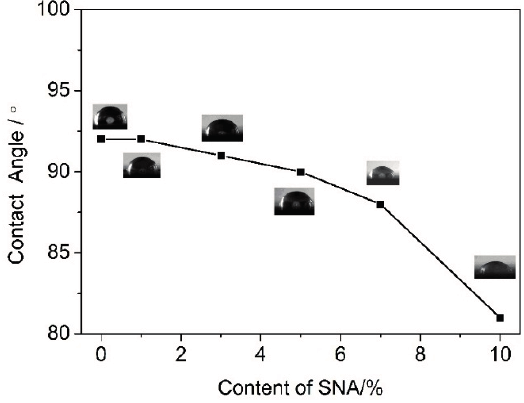
Figure 8. Static water contact angle for CL and